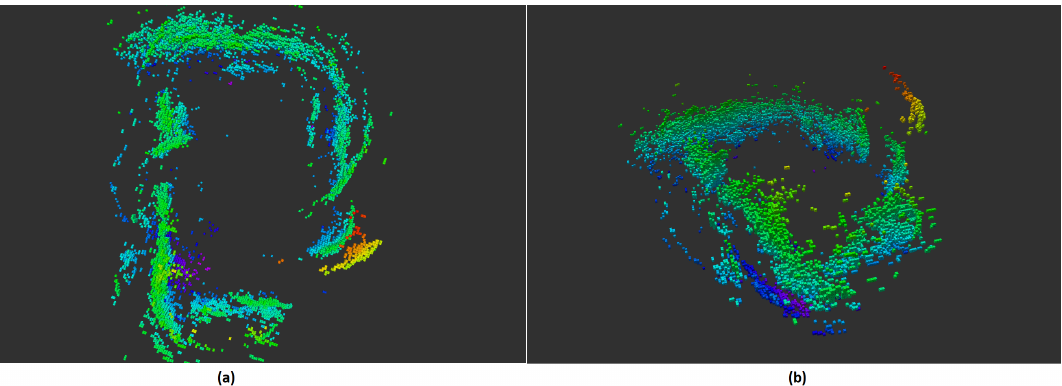
Figure 16. Three-dimensional map used only ultrasound sensor with color represents the voxel’s height ( a ): top view ( b ): side view.